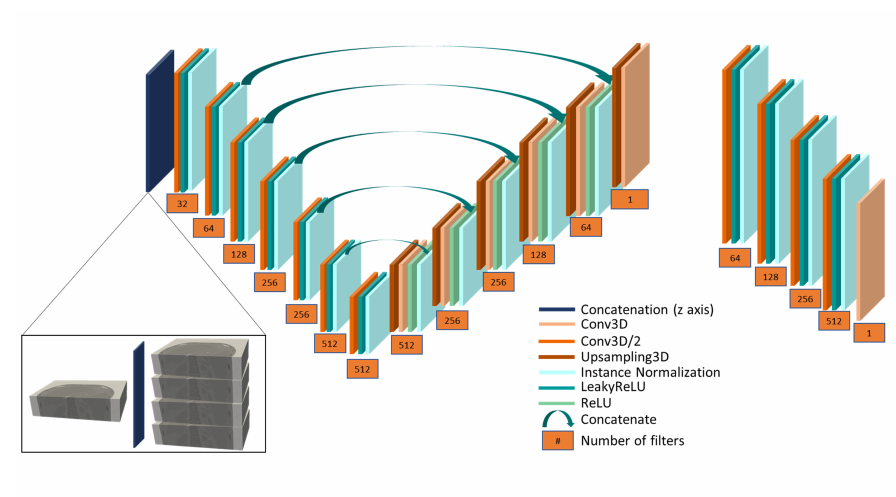
Figure 4. Network architectures; left —U-net like generator; right —patch discriminator. The first layer of the generator performs a 4 × repetition of the thin input to define the extrapolation